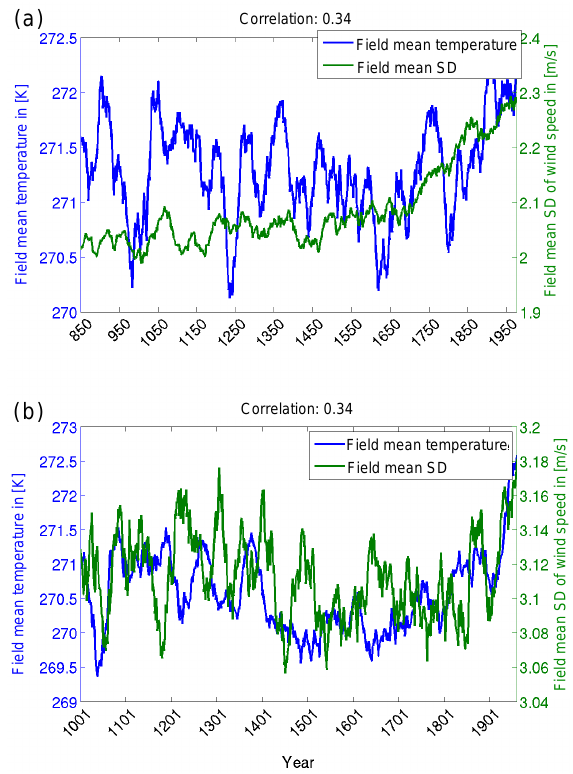
Figure 9. Time series of 30-year running mean values of mean tem- perature (blue) and the standard deviation (SD) of the wind speed (green) for the GCMs ECHAM6 (a) and ECHO-G (b) . In both mod- els the correlation between the blue and the green line is